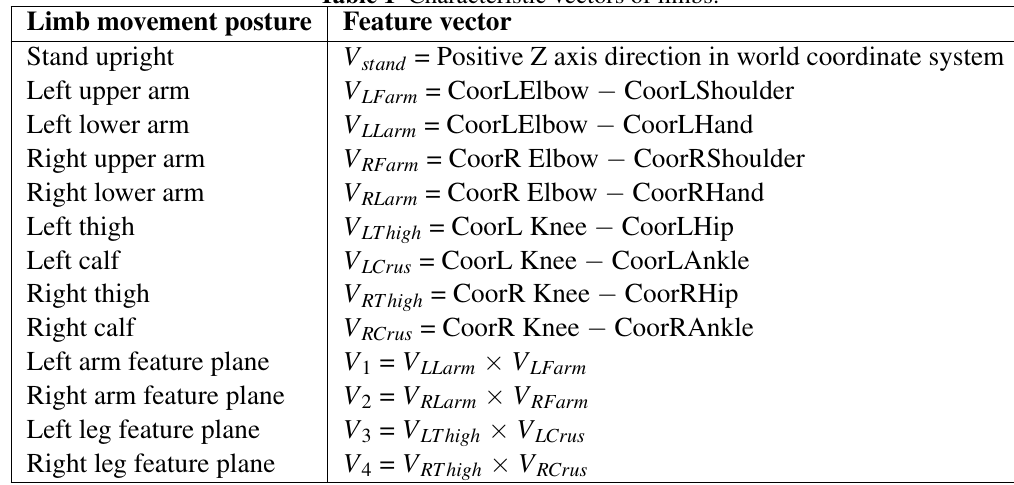
Table 1 Characteristic vectors of